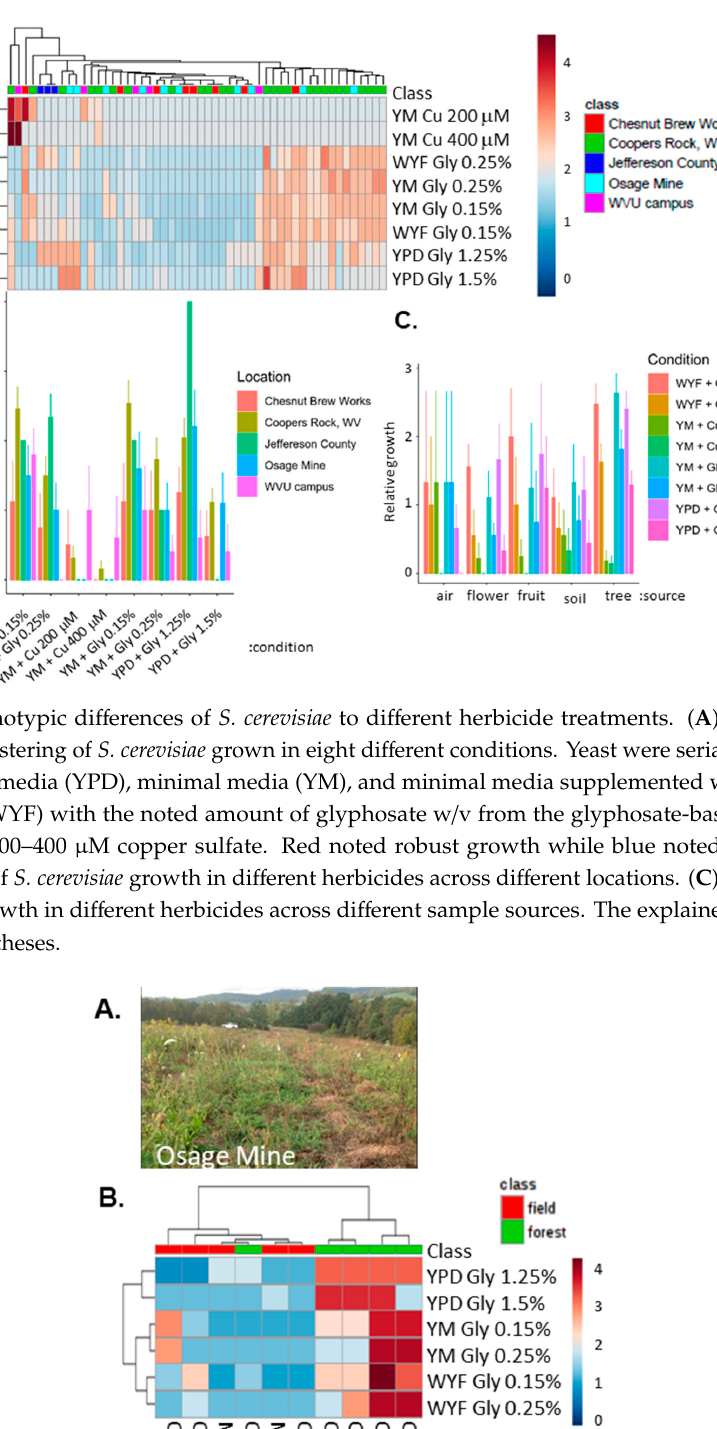
Figure 5. Phenotypic differences of S. cerevisiae to different herbicide treatments. ( A ) Heatmap of hierarchical clustering of S. cerevisiae grown in eight different conditions. Yeast were serial diluted and grown on rich media (YPD), minimal media (YM), and minimal media supplemented with aromatic amino acids (WYF) with the noted amount of glyphosate w/v from the glyphosate ‐ based herbicide (Credit41) or 200–400  M copper sulfate. Red noted robust growth while blue noted less growth. ( B ) Bar graph of S. cerevisiae growth in different herbicides across different locations. ( C ) Bar graph of S. cerevisiae growth in different herbicides across different sample sources. The explained variance is noted in parentheses.